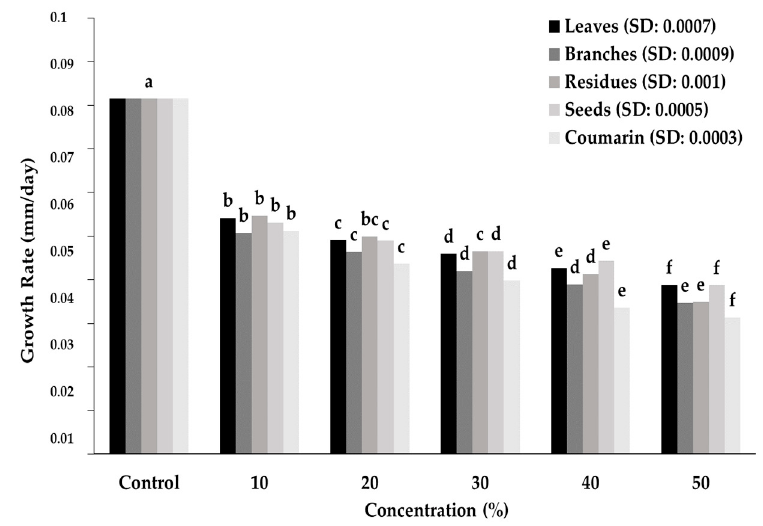
Figure 4. Mycelial growth rate of Colletotrichum musae subjected to different concentrations of ethanolic extracts of Dipteryx punctata and coumarin standard. SD = standard deviation. Means followed by the same lowercase letters in the columns do not differ from each other by Tukey’s test ( p ≤ 0.05).